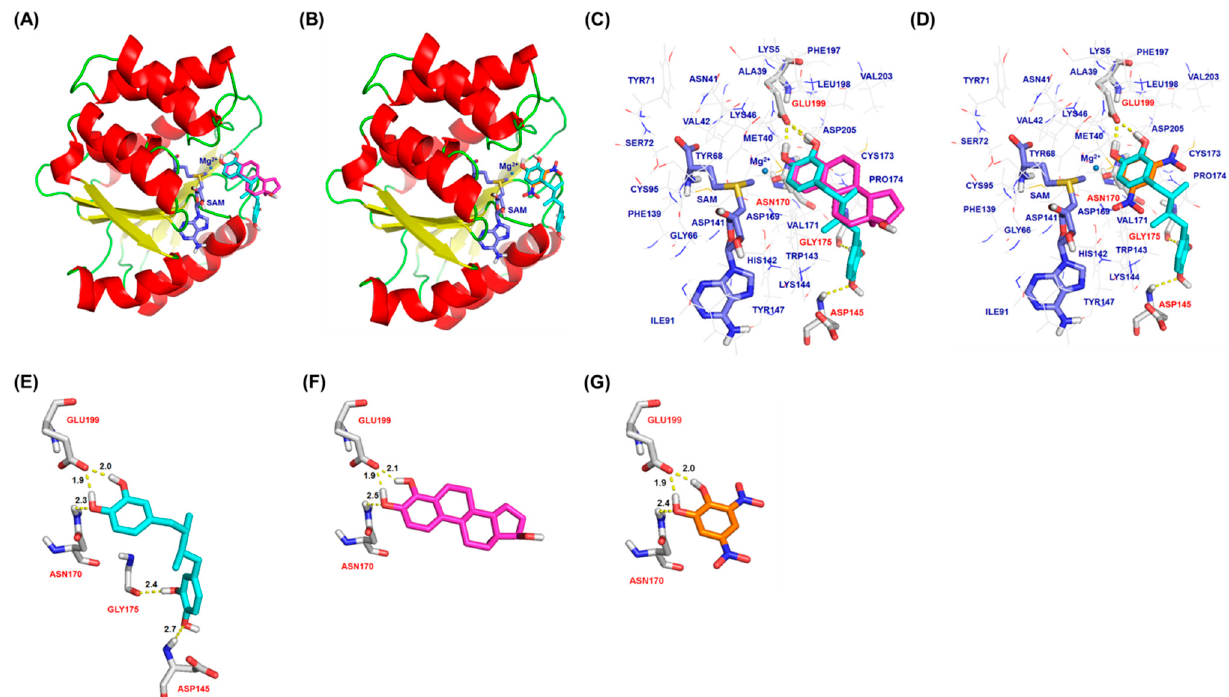
Figure 3. Computational models for human catechol O -methyl transferase bound with 4-hydroxyestradiol, dinitrocatechol (DNC), and nordihydroguaiaretic acid. Binding conformation for COMT bound with NDGA and 4-OHE 2 ( A ), and NDGA and DNC ( B ) in a ribbon representation. The secondary structure backbone of human COMT (PDB code 3BWM) is represented as a cartoon and colored red for the helix, yellow for the sheet, and green for the loop. S -adenosyl-L-methionine (SAM; violet), Mg 2+ (blue sphere), NDGA (cyan), 4-OHE 2 (magenta), and DNC (orange) all bound on the protein surface of the binding site of human COMT. Superimpositions of NDGA (cyan) and 4-OHE 2 (magenta), and NDGA and DNC (orange), at the human COMT active site are shown as stick representations ( C ) and ( D ), respectively. The amino acid residues involved in the key hydrogen bonding interactions are depicted by atom type: carbon atoms in gray, nitrogen atoms in blue, sulfur atoms in yellow, and oxygen atoms in red. Polar hydrogen bonds are shown as yellow dashed lines. A comparative view of the hydrogen bond interactions between COMT and NDGA (cyan) ( E ), 4-OHE 2 (magenta) ( F ), and DNC (orange) ( G ) is shown as a stick representation. Numbers presented adjacent to yellow dashed lines represent the calculated length of the hydrogen bond in Å.